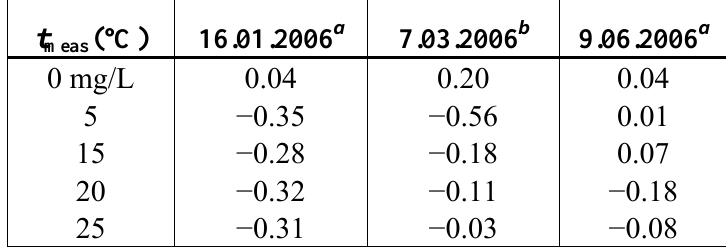
Table 4. Bias estimates obtained from the reference measurements and interlaboratory comparisons.